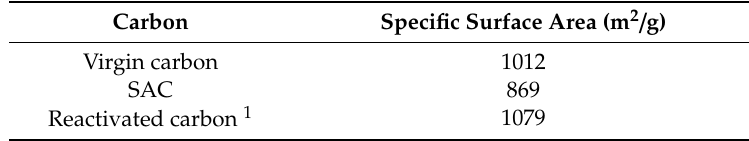
Table 2. Specific surface area (m 2 / g) of virgin carbon, SAC, and reactivated carbon.